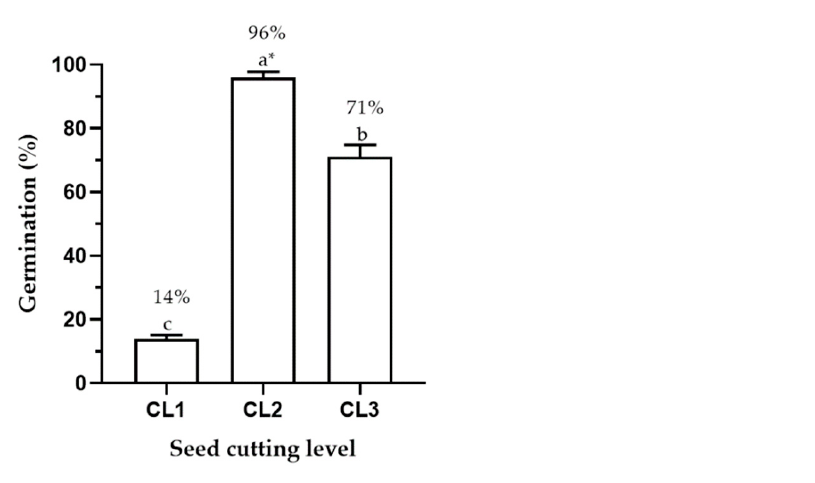
Figure 8. Histological cross section of A. pelegrina seeds at different maturity stages of fruits. FR3: Fruit stage 3; FR4: Fruit stage 4; FR5: Fruit stage 5; Em: embryo; En: endosperm. Red bars represent the distance between the position of the embryo and the apical zone of the seed. Scale bar: 1000 um. 4. Discussion A. pelegrina is a perennial herbaceous plant. Similar to other species in the genus, it has a senescent aerial part that disappears from the soil surface in late summer, only to re- emerge from rhizomes in late fall and flower again in spring [12]. In the study area, the complete reproductive period was 71 days, with individual flowers lasting up to 9 days. The long-lasting flowers were noted by [35], who recorded an average flowering period